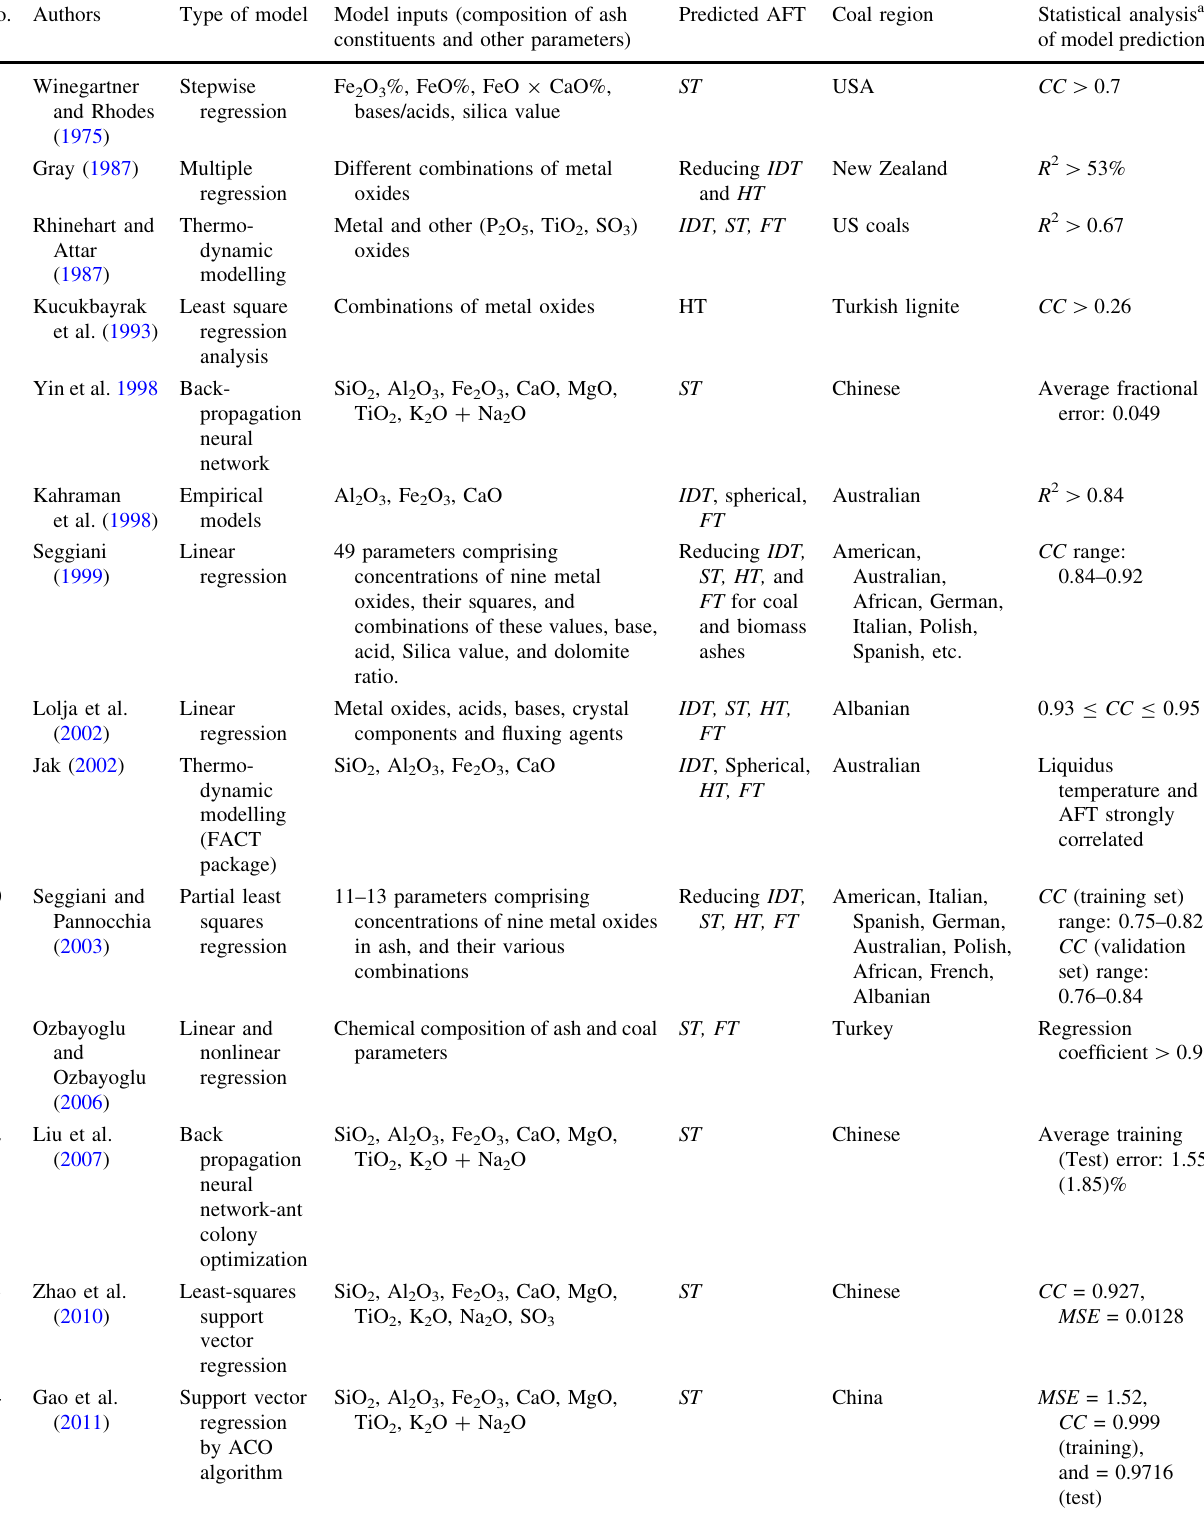
Table 1 A representative compilation of AFT predicting